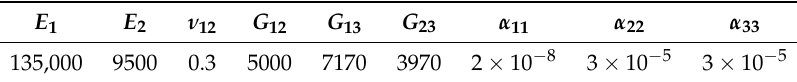
Table 1. Material properties of the unidirectional AS4 pre-preg carbon fiber. The units for the stiffnesses are N/mm.